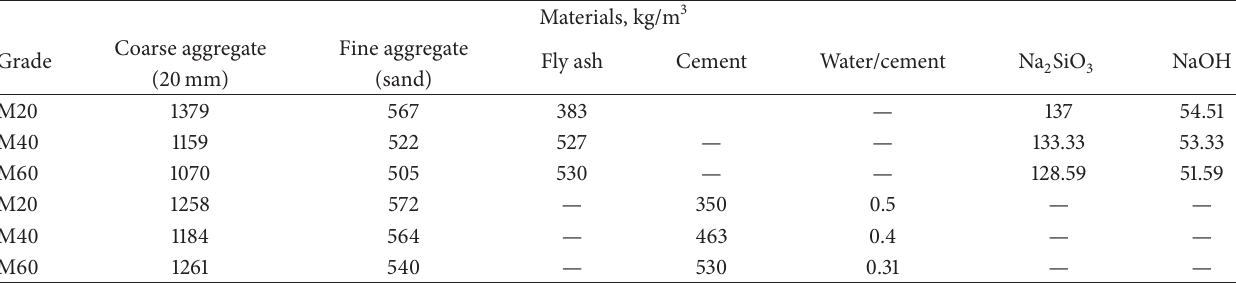
Table 2: Mix proportions of GPC and